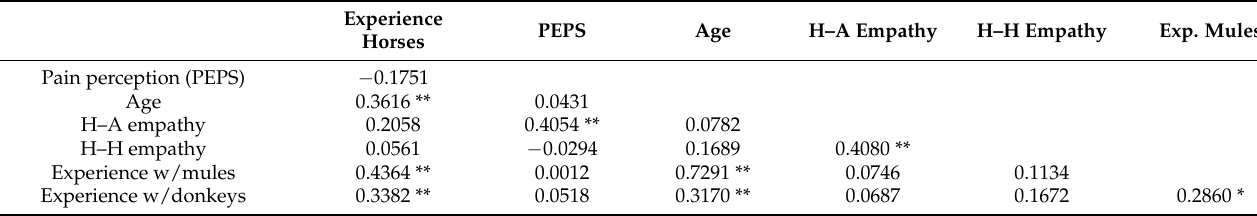
Table 4. Spearman’s correlation matrix (R-values) for the pain perception, human–human (H–H) and human–animal (H–A) empathy tools, age and experience with horses, mules and donkeys.